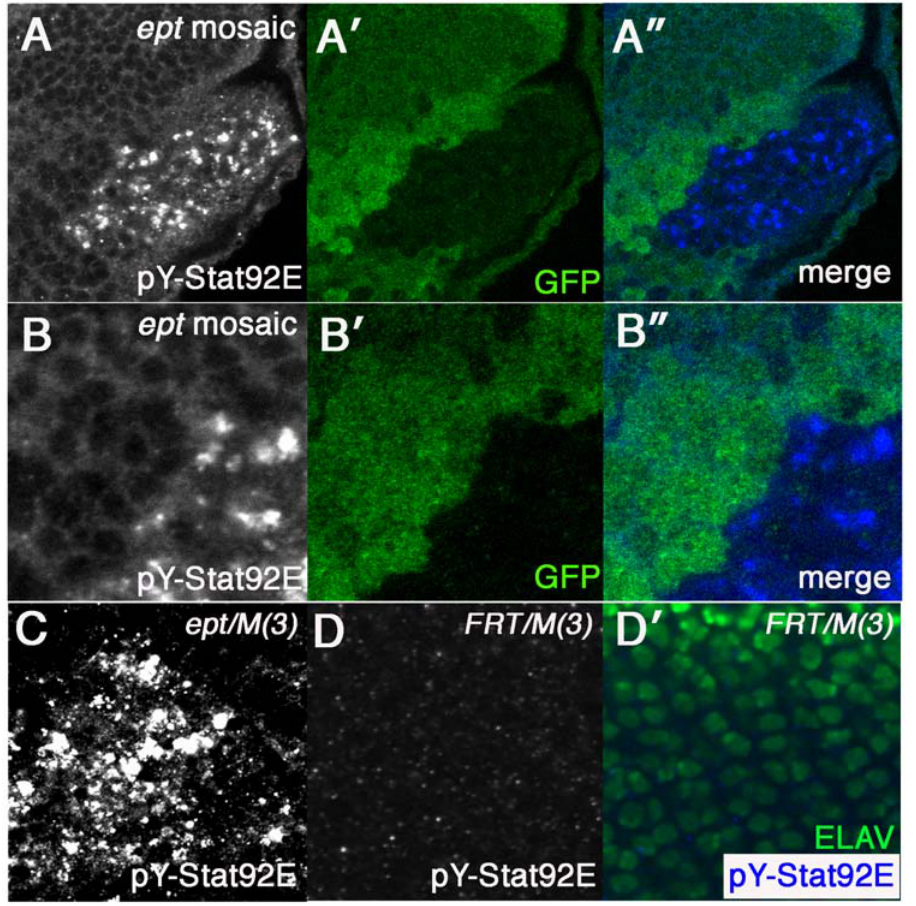
Figure 4. pY-Stat92E levels in ept mutant eye disc cells. A clone of ept 2 mutant eye disc cells (A–B) marked by the absence of GFP (green) and stains brightly for the pTyr-Stat92E epitope (blue). Note the pY-Stat92E epitope is specifically enriched within ept 2 mutant clones. Anti-pY-Stat92E signal in an ept 2 /M(3) eye-antennal tumor (C) and in a control FRT80B/M(3) eye antennal disc posterior to the morphogenetic furrow (D). Areas imaged in panels A, B, and D are posterior to the MF; the tumor in panel C has no MF.